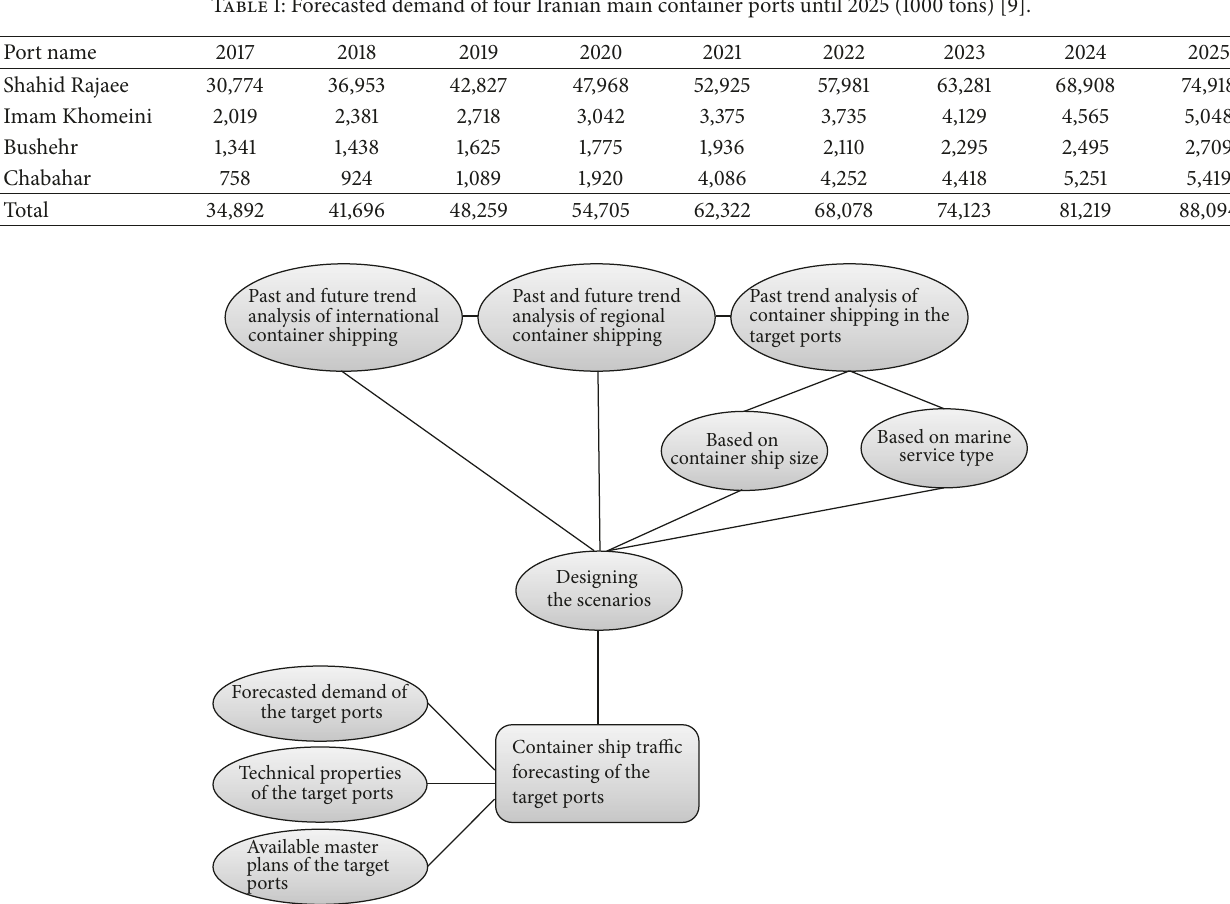
Figure 2: Methodology of traffic forecasting in target